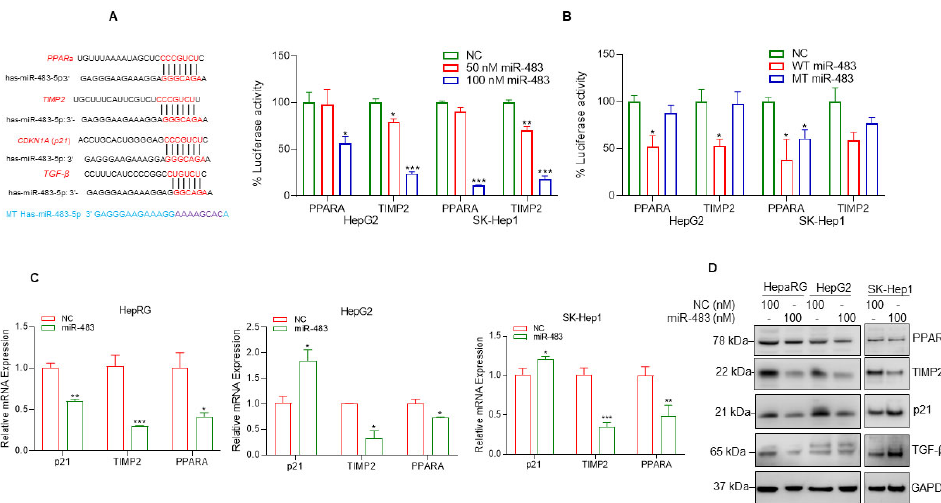
Figure 6. miR-483 targets PPARa and TIMP2 UTRs and inhibits their expression. ( A ) The Figure 6. miR ‐ 483 targets PPARa and TIMP2 UTRs and inhibits their expression. ( A ) The binding sites of miR ‐ 483 in the 3 ′ UTR of PPARA (5), TIMP2, and p21 gene were analyzed by TargetScan